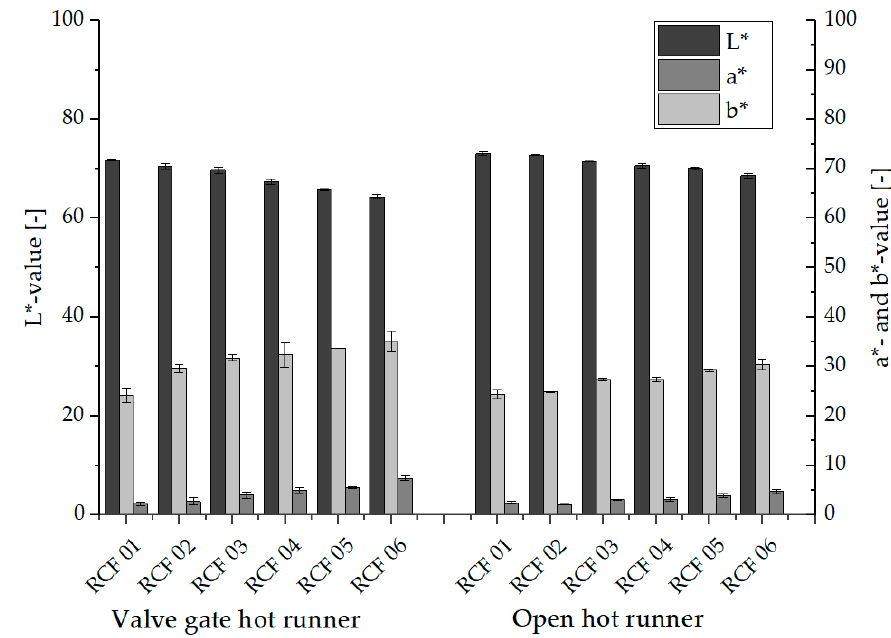
Figure 6. L*a*b*-values of the RCF und GF reinforced composites.